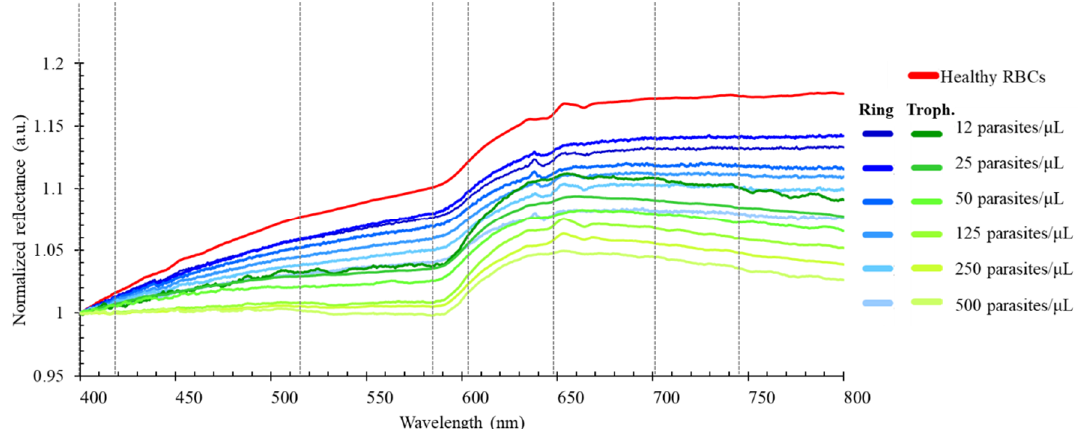
Figure 1. Normalized reflectance spectra (a.u.) of uninfected RBCs (in red) and RBCs with early (rings, in blue) and late (trophozoites, in green) parasites, with different P. falciparum parasitaemia, from 12 to 500 parasites/μL of RBCs, in the 400–800 nm range of the optical spectrum ( n = 3) [9]. The vertical dashed lines represent the 8 selected spectral bands.